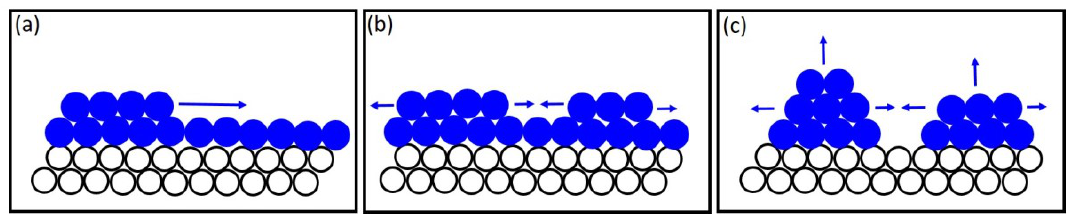
Figure 9. A schematic of the ‘nucleation-coalescence’ growth mechanism, where: ( a ) a few monolayers of InSb grow on the Au electrode; ( b ) islands from over the monloayer; ( c ) coalescence of the islands to form individual crystals/grains.